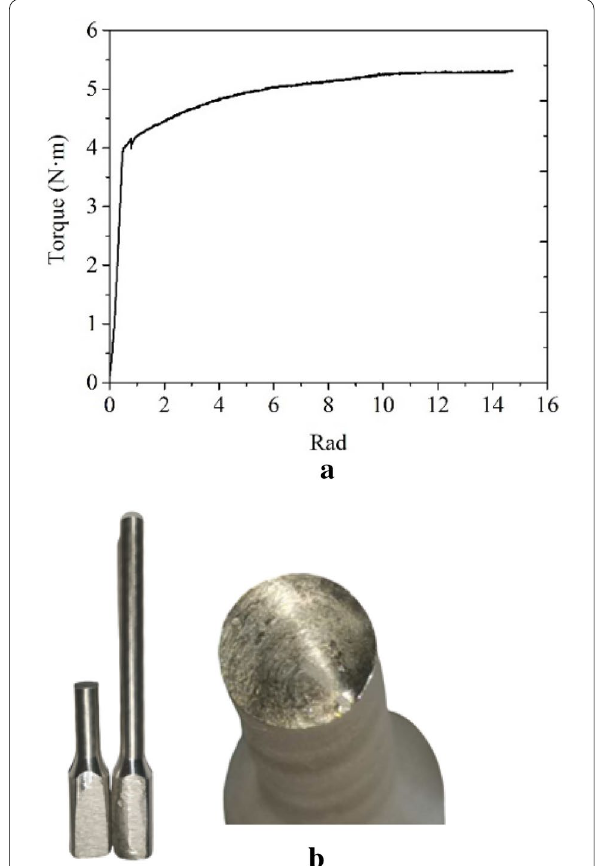
Figure 6 Torsion test: a Torque–rad relationship of the torsion test. b Fracture phenomena in the torsion test